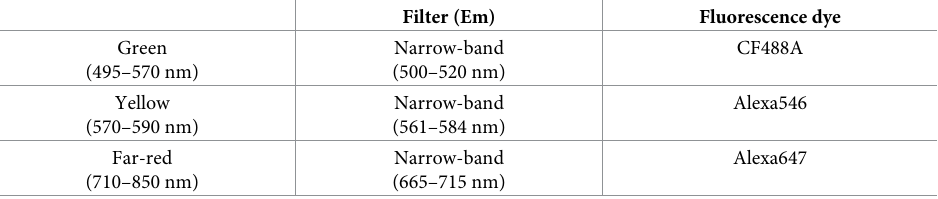
Table 1. Optimized combinations of filter and fluorescence dye in each color wavelength region.